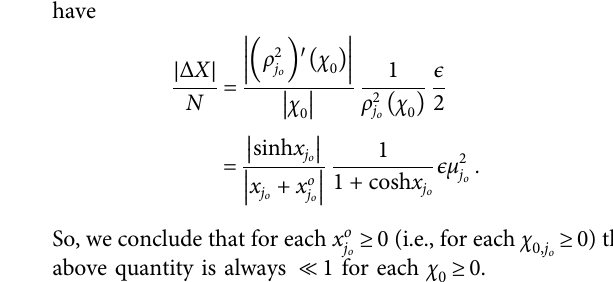
FIGURE 3 | Plot of Δ X / N as a function of x with μ j α (cid:2) − 10, α (cid:2) − 15 and ϵ μ 2 (cid:2) 10 − 2 , but with different values of the bounce, j 1 j 2 givenby